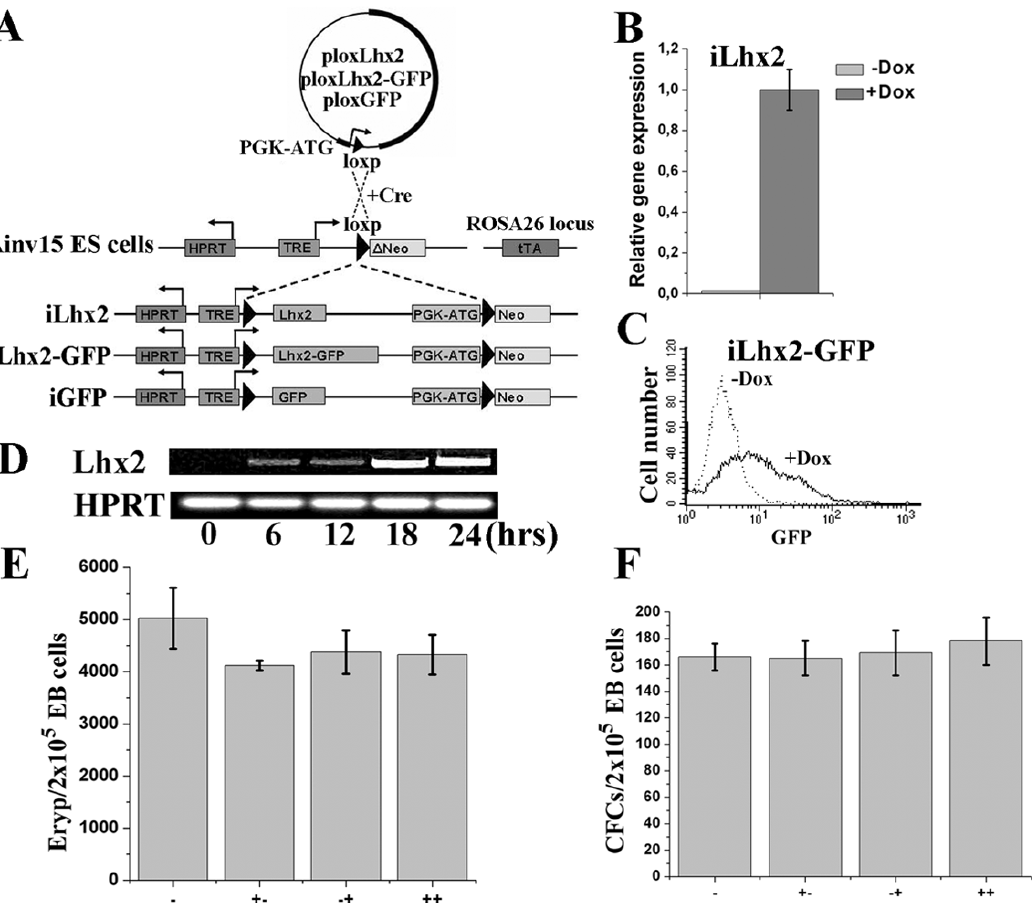
Figure 1. Generation of ES cell lines with inducible gene expression. A. The iLhx2, iLhx2-GFP and iGFP ES cell lines were generated by co- transfecting Ainv15 ES cells with the plox vector containing the respective gene construct together with a vector containing the Cre recombinase as described in ref. 45. The plox vector will be inserted into the loxp site down stream of the tet-responsive element (TRE) adjacent to the Hypoxanthine- phosphoribosyltransferase ( HPRT ) gene. The reverse tet transactivator (rTA) is inserted into the ubiquitously expressed ROSA26 locus in the Ainv15 ES cells. B. Lhx2 expression is measured by real-time PCR analysis of iLhx2 ES cells cultured in the absence ( 2 Dox) or presence ( + Dox) of dox for 2 days. C. FACS analysis of the iLhx2-GFP ES cells cultured in the absence (-Dox) or presence ( + Dox) of dox for two days. D. Lhx2 expression measured by RT- PCR at different time points (in hrs) after dox addition to iLhx2 ES cells. Expression of HPRT was used as an internal control. E. Analysis of EryP precursor cells in day 6 EB when dox is added to the control iGFP ES cells at different stages during in vitro differentiation. F. Analysis of definitive CFCs in day 6 EBs when dox is added to iGFP cells at different stages of ES cell differentiation. – control, no addition of dox, + 2 addition of dox during ES cell differentiation from day 0 to day 6, 2 + addition of dox to the clonal assays of the EB cells, ++ addition of dox to both the ES cell differentiation from day 0 to day 6 and to the clonal assays of the EB cells.